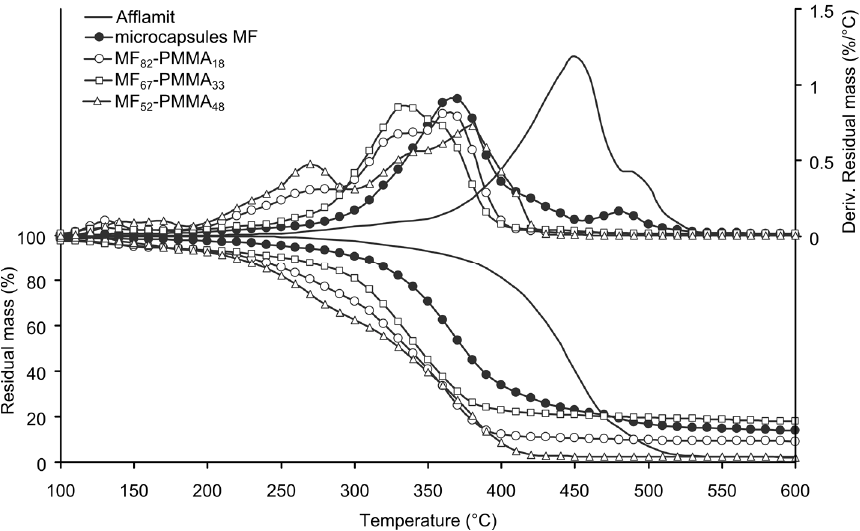
Figure 5. TG and DTG of RDP, MF microcapsules, and PMMA-based microcapsules (N 2 , 10 °C/min).